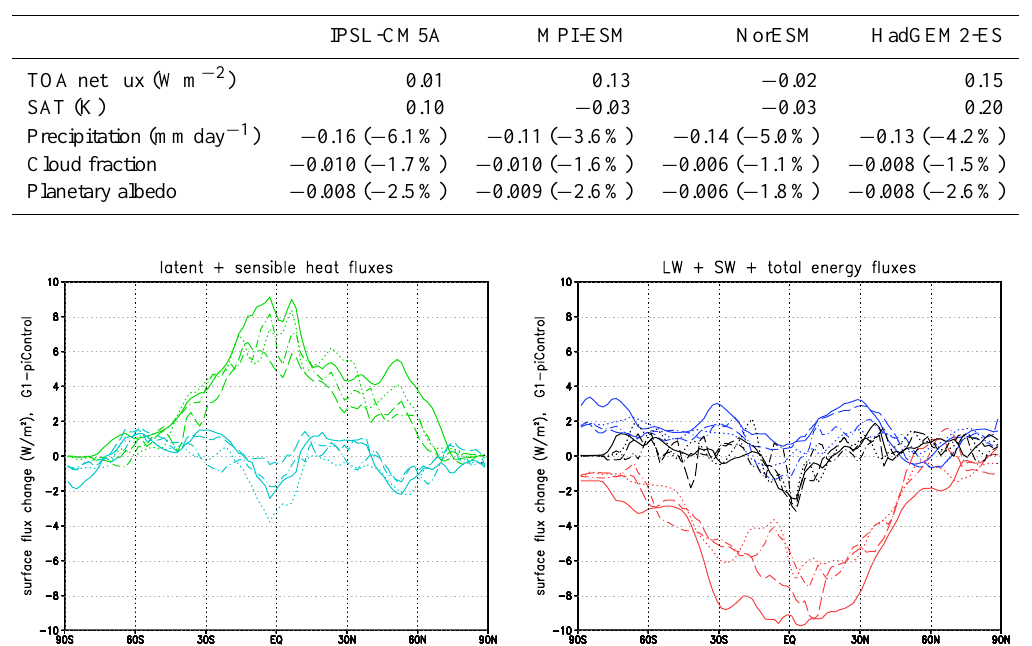
Table 3. Comparison of differences between the geoengineered and preindustrial climates (G1 – piControl) in globally-averaged parameters.